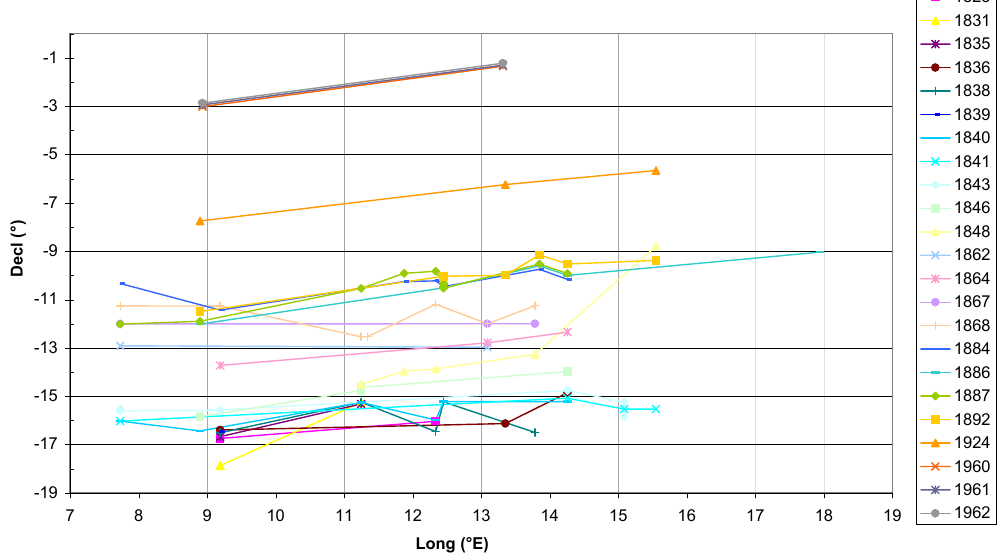
Fig. 4. Declination values measured during the same year at different Italian sites (since 1825 and relocated to Stromboli via the pole method) versus site longitude values.